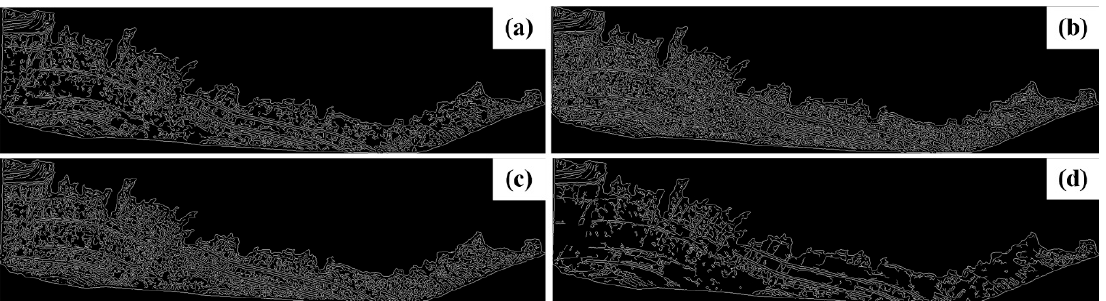
Figure 8. Comparison of the sensitivity thresholds of the Canny operator: ( a ) the self-adapt threshold; ( b ) the threshold of upper 0.01 and lower 0.004; ( c ) the threshold of upper 0.02 and lower 0.008; and ( d ) the threshold of upper 0.05 and lower 0.02.